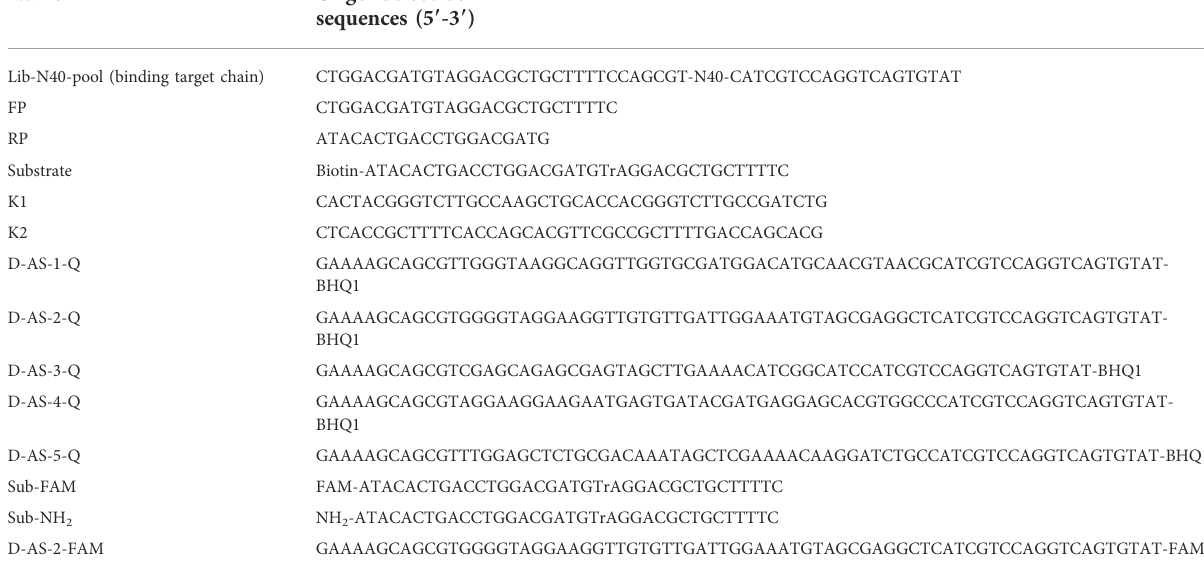
TABLE 1 Library and primer sequences. Name Oligonucleotide sequences (5 9 -3 9